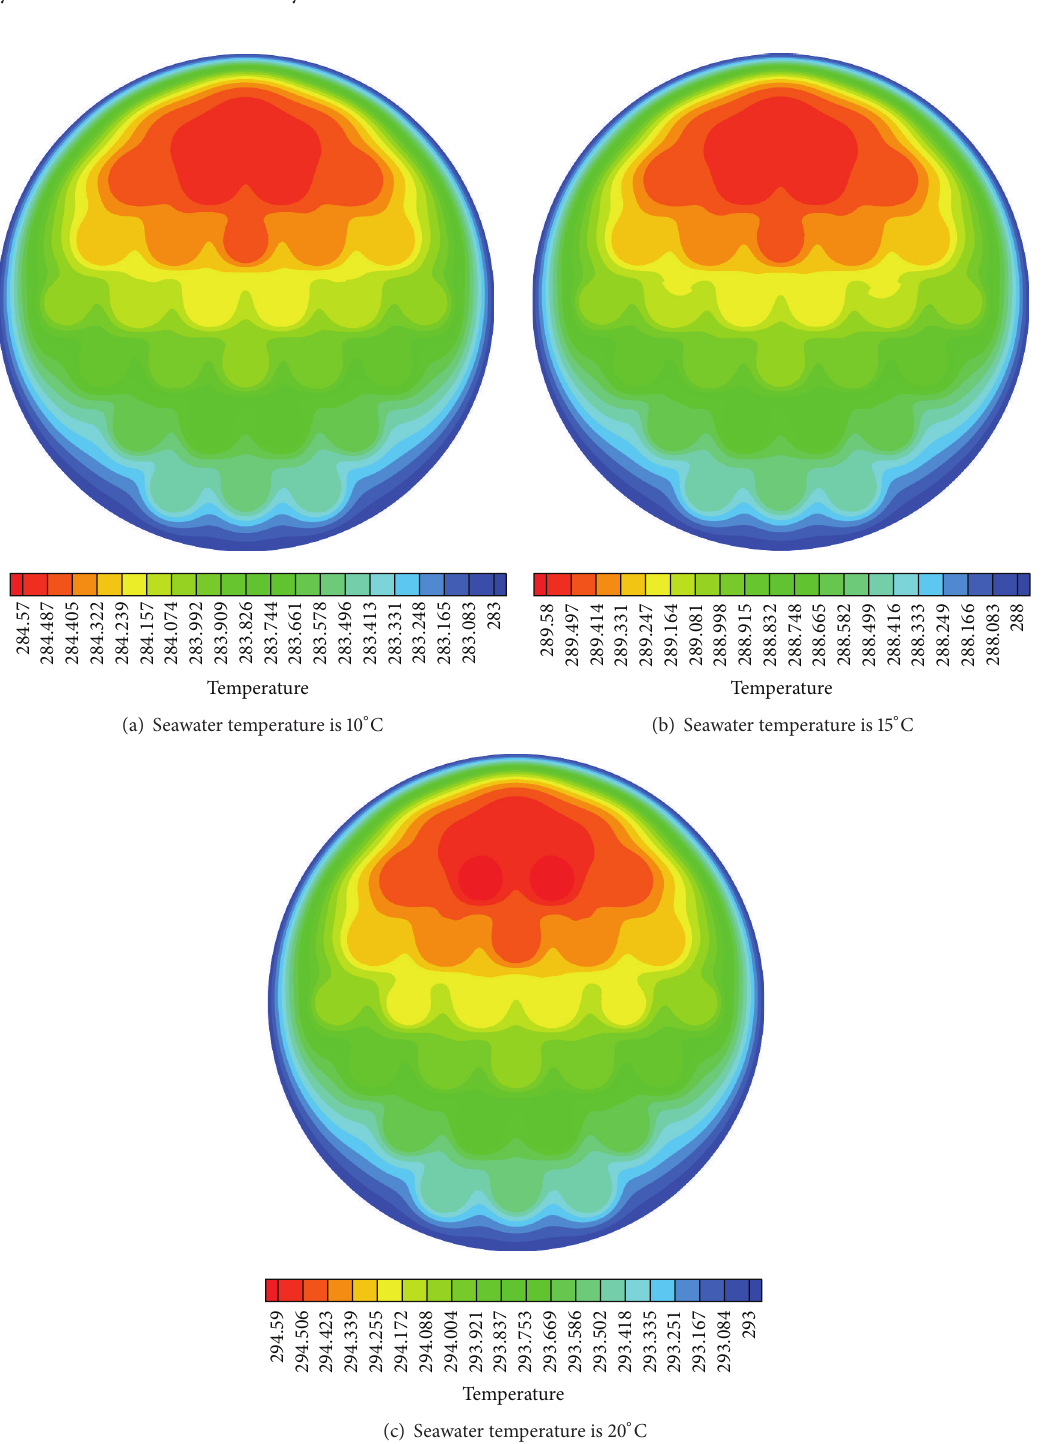
Figure 10: The battery compartment temperature distribution when the speed is 4